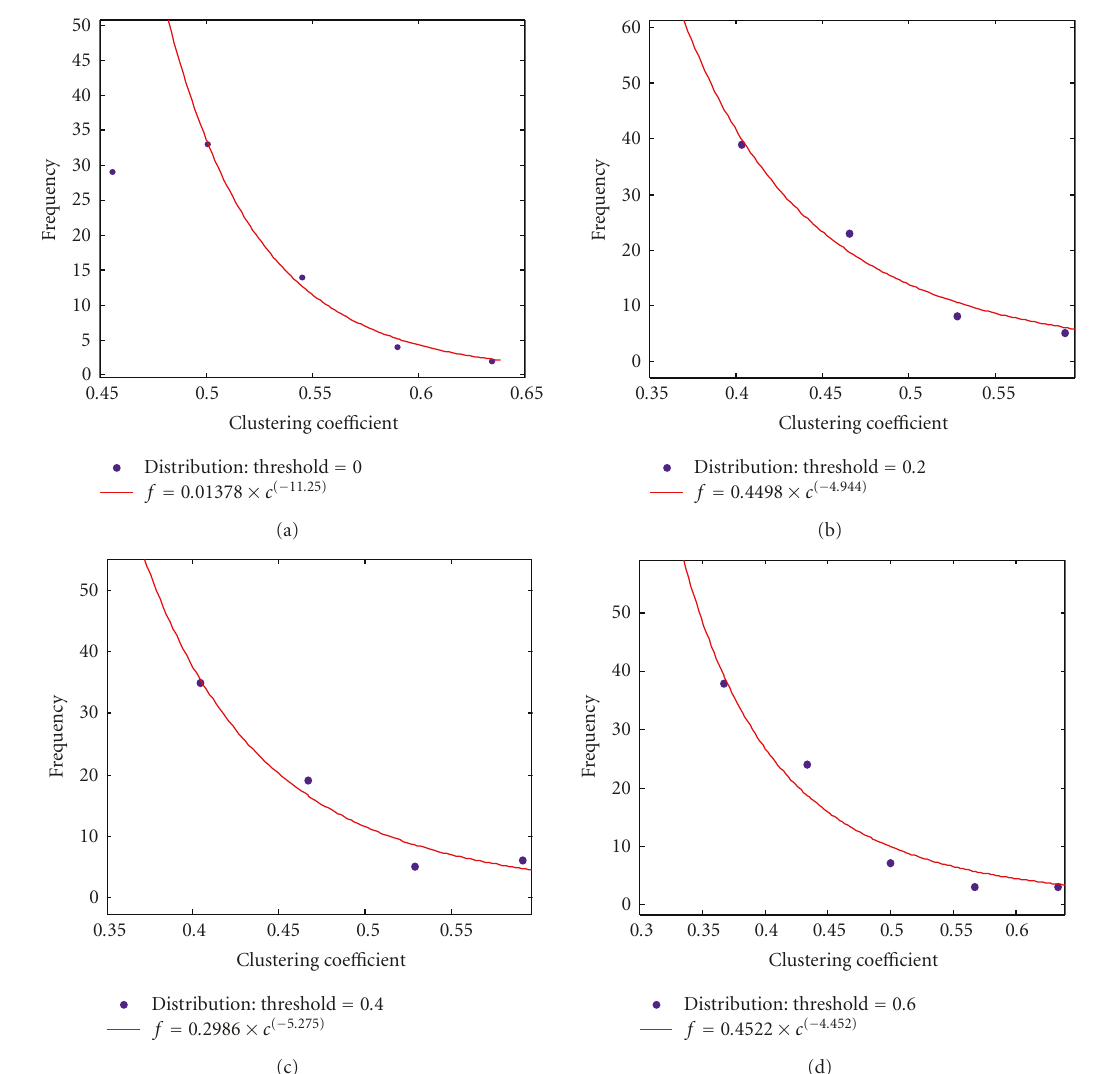
Figure 10: Power law for distribution of clustering coe ffi cient (MATLAB): dataset B. convention for the links (edges). Recall that this is a directed graph. The direction of the edges is not shown and instead the following convention is used for illustration